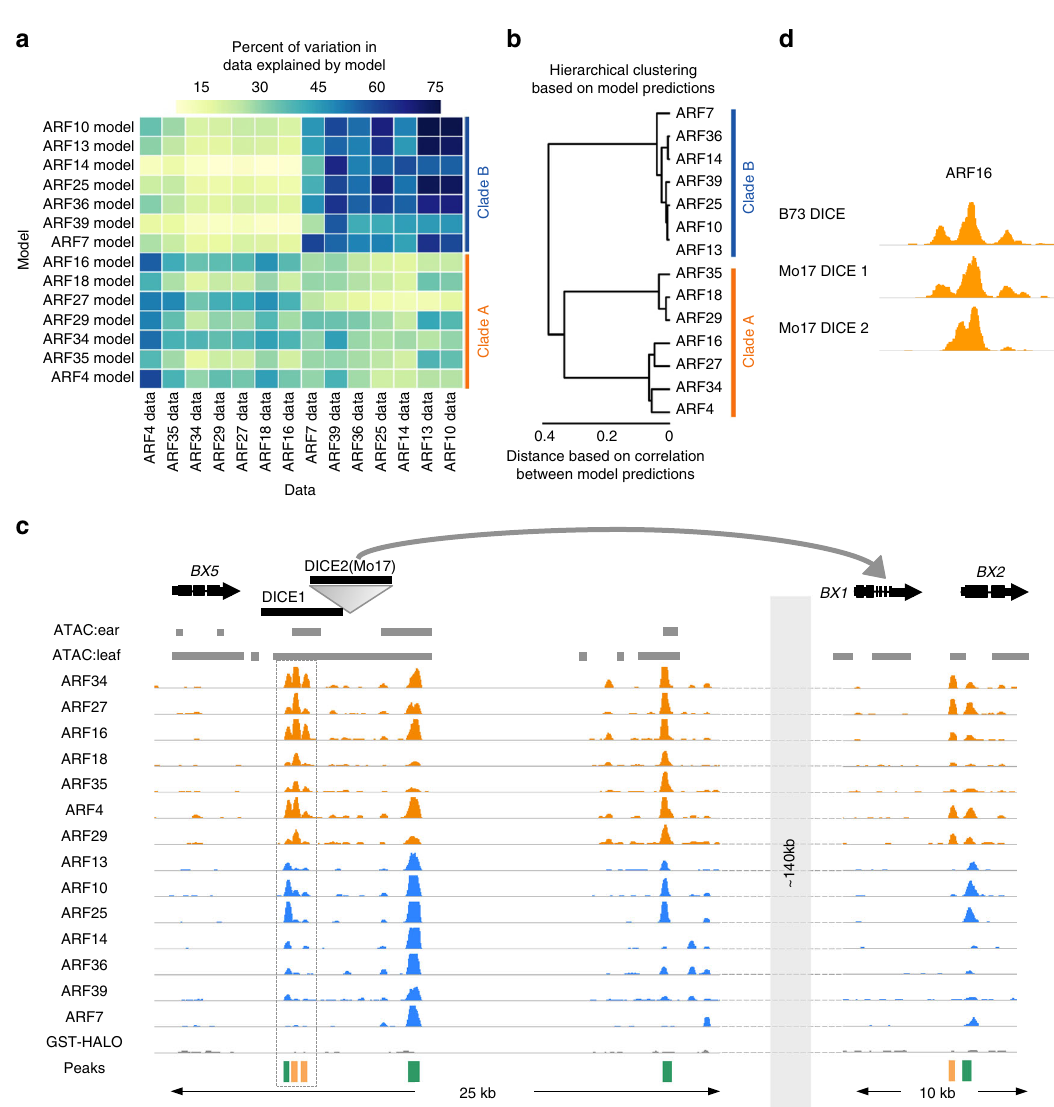
Fig. 6 ARFs display predictive cis -regulatory signatures. a Heatmap showing percent of variation in ARF binding data that can be explained by a machine learning model trained on individual ARF datasets. b Hierarchical clustering of ARFs based on model predictions. c Genome browser view of ARF binding events in the 30 kb region surrounding the DICE element and the BX1 genic region located 140 kb downstream that is controlled by DICE. d Empirically determined ARF16 peaks located in the B73 DICE, Mo17 DICE 1, and Mo17 DICE 2 elements as determined by